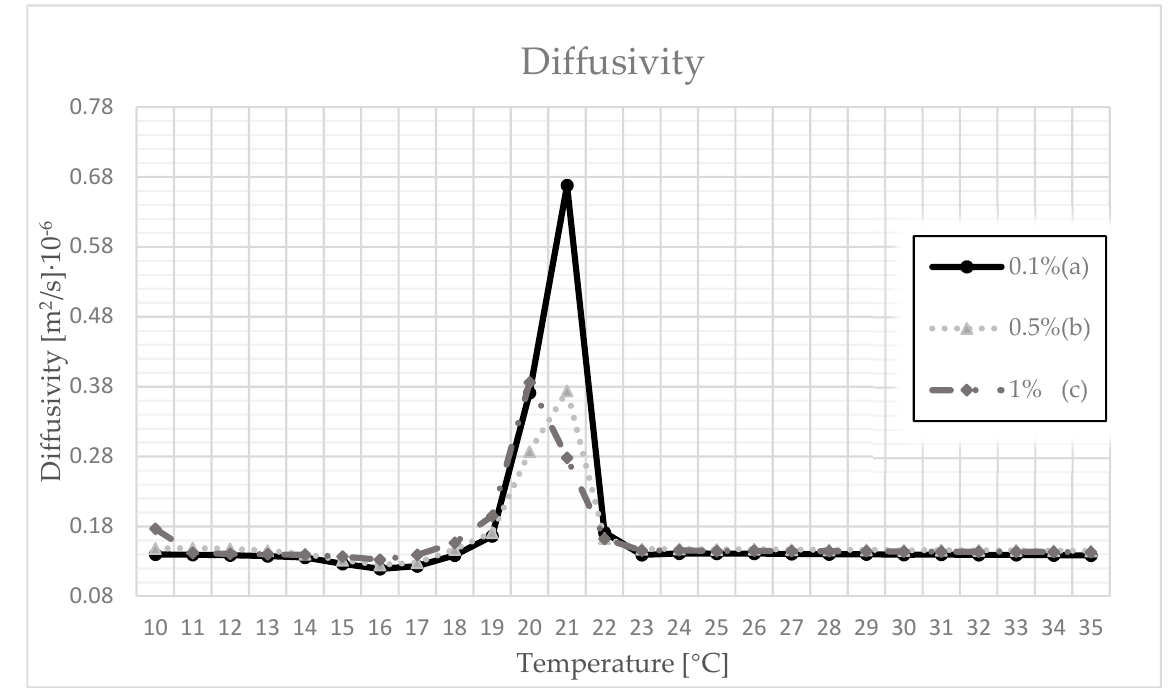
Figure 5. Changes in the value of thermal diffusivity as a function of temperature for different percentages of polymer in the composites with (a) 0.1% polymer; (b) 0.5% polymer; (c) 1% polymer Table 5. Results obtained during measurements of gypsum thermal coefficients.